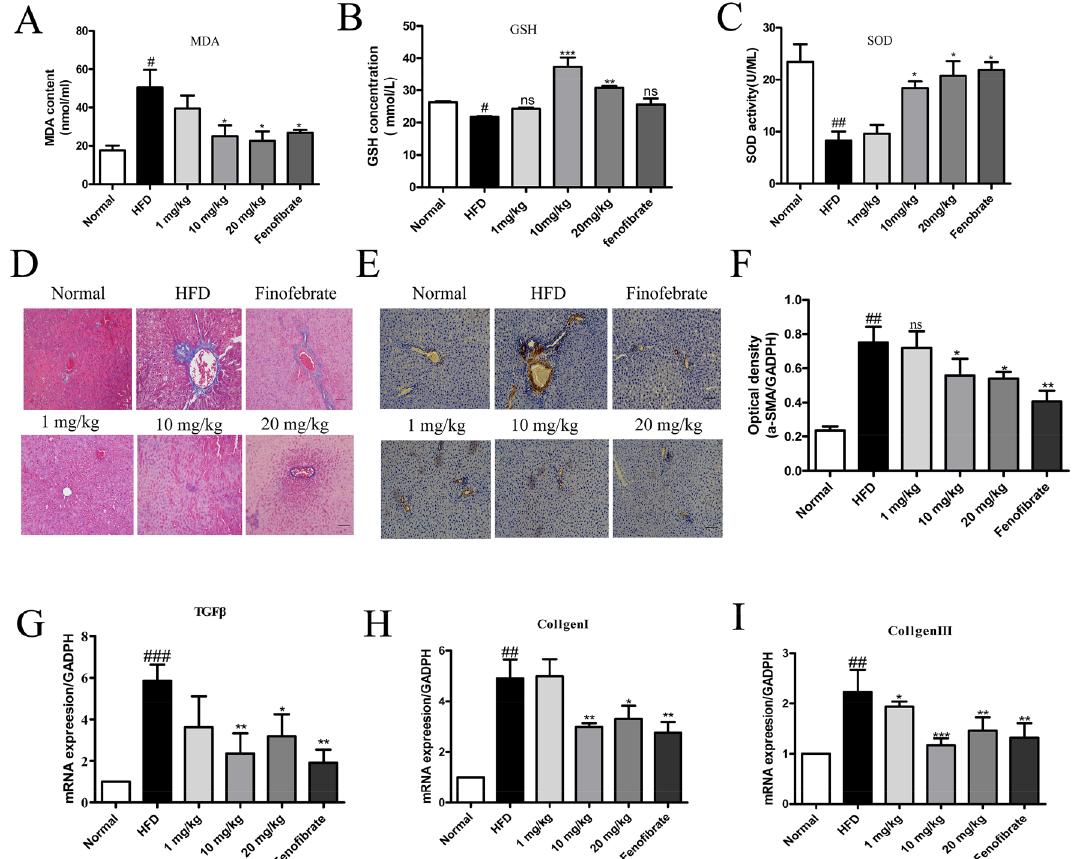
Figure 6. STVNa suppresses hepatic oxidative stress and fibrosis. ( A – C ) Total MDA content, GSH level and GSH level in NAFLD rats at week 10. ( D ) Masson staining. ( E , F ) IHC measurements of α-SMA. 200 × magnification; Scale bar = 100 µm. ( G – I ) The expression levels of TGFβ, Collagen I and Collagen III in NAFLD rats after 5 weeks of STVNa treatment (n = 3 per group). * P < 0.05, ** P < 0.01 and *** P < 0.001 vs. HFD-fed rats; ## P < 0.01 and ### P < 0.001 vs. ND-fed